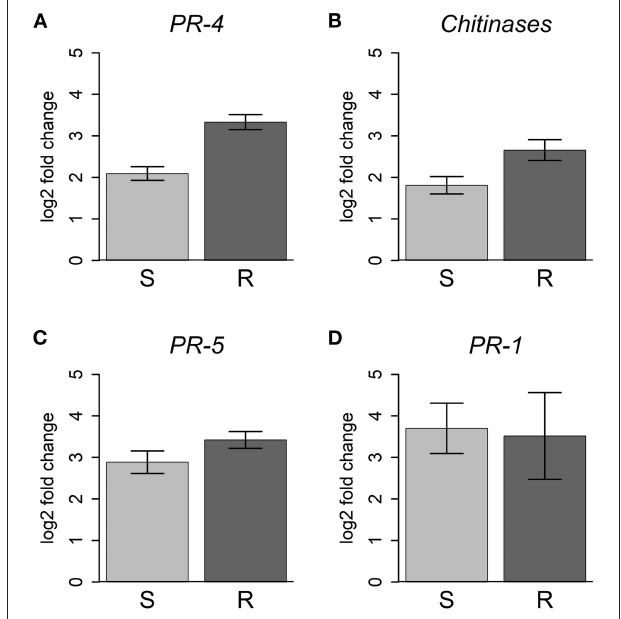
FIGURE 7 | Differential expression of PR and chitinase genes. For each gene family, the average of the log2(fold change) is represented for resistant (R) and susceptible (S) plants, compared to controls. Error bars represent the standard error of the mean. (A) PR-4 , 3 genes; (B) chitinase , 25 genes; (C) PR-5 , 16 genes; (D) PR-1 , 4 genes. For more details about the genes used and respective functional annotations see Supplementary Table 9 .